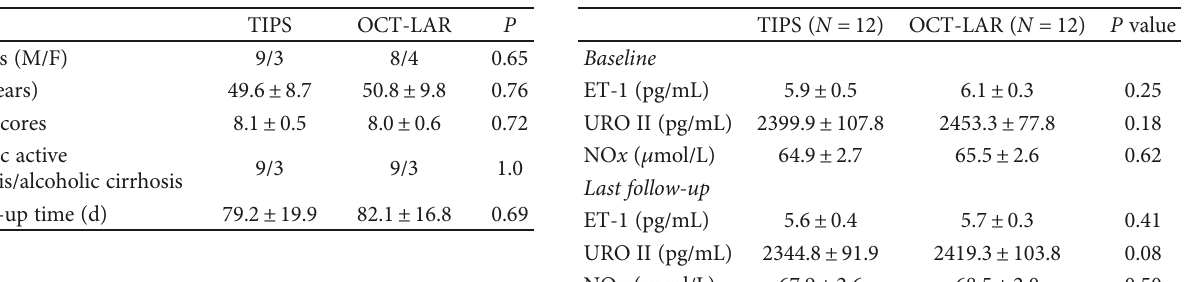
Table 3: Biological values at baseline and last follow-up.